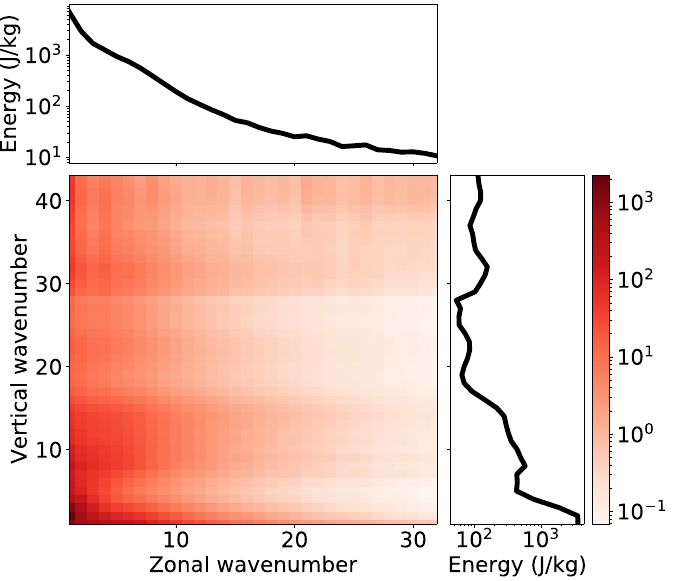
Figure 5. Energy spectrum of the atmospheric oscillations as a function of the zonal wavenumber and the vertical mode